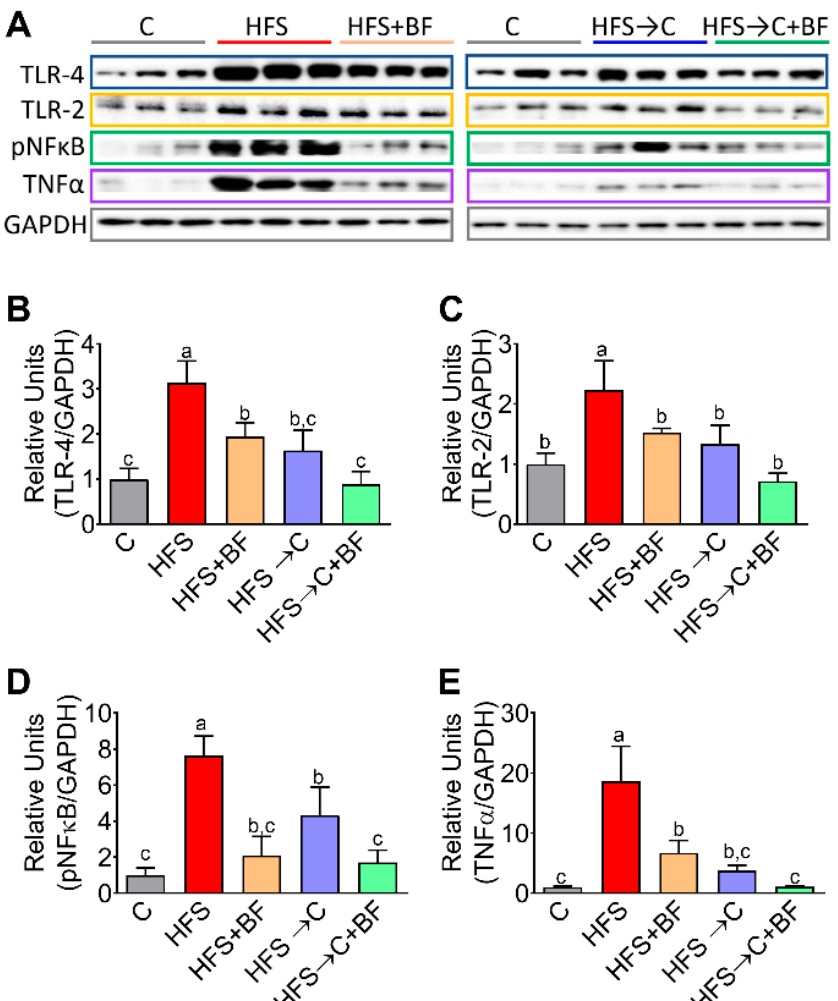
Figure 5. Liver inflammation decreased by consumption of bioactive foods. ( A ) Western blot analysis, ( B ) Protein abundance by ( B ) TLR-4, ( C ) TLR-2, ( D ) pNF κ B and ( E ) TNF α in liver of rats fed control ( C ) or high fat diet+5% sucrose (HFS) with or without bioactive. Data are expressed as the mean ± SD. Mean values with different letters show statistical differences between each other. Data was analyzed by one-way ANOVA fol-lowed by Tukey post-hoc test. Results were considered statistically significant at p < 0.05.